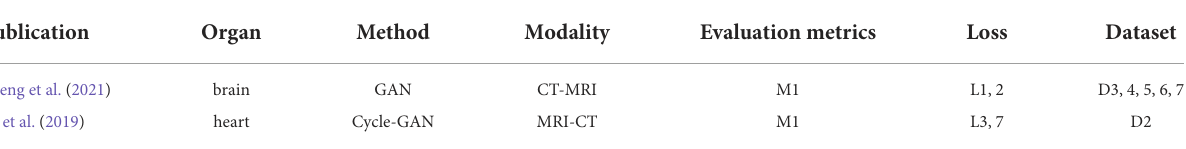
TABLE 3 Overview of symmetric learning-based